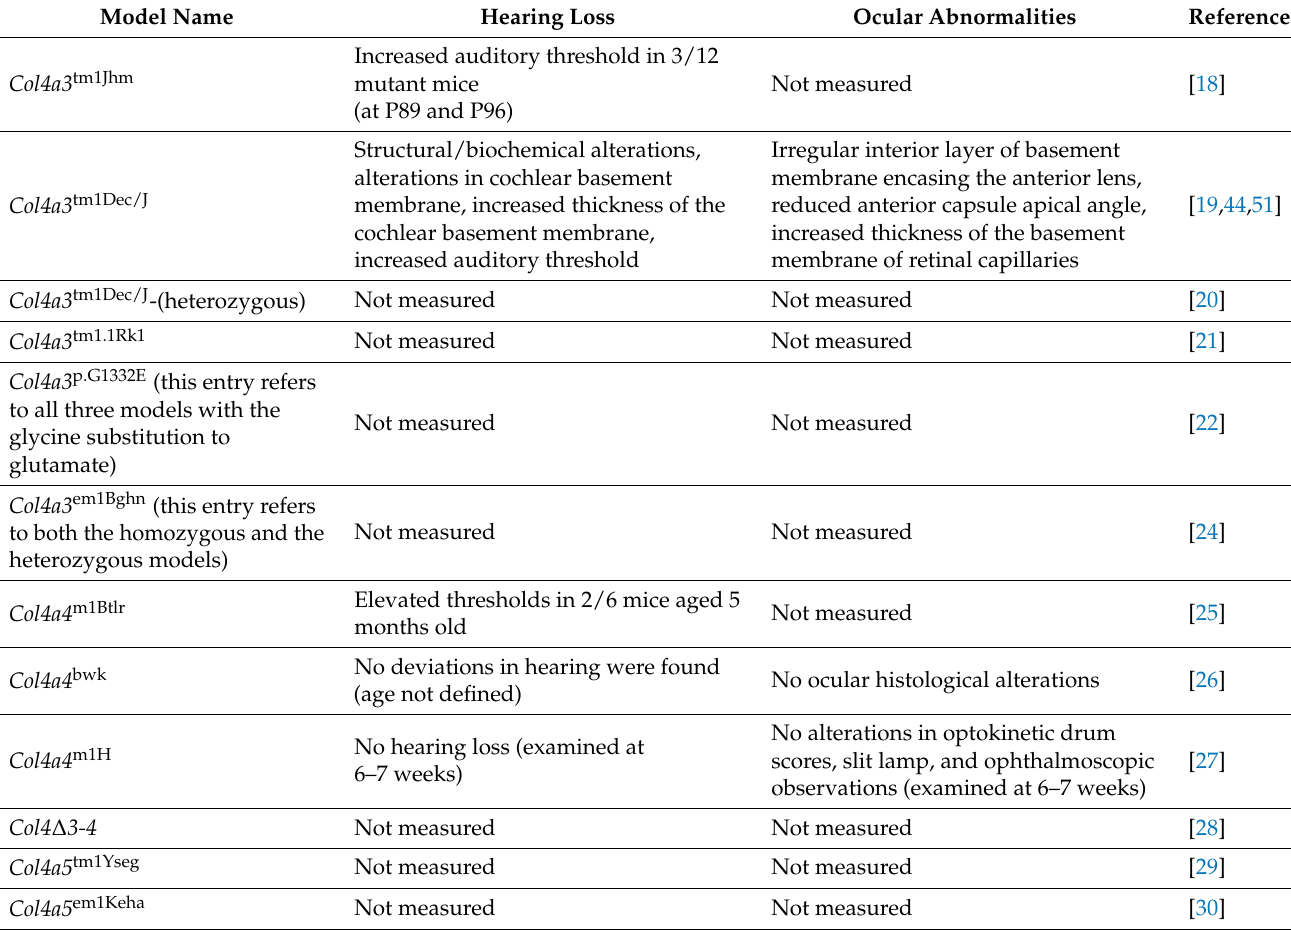
Table 3. Ocular and hearing defects occurring in the mouse models of Alport